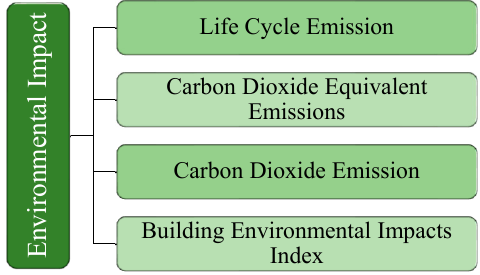
Figure 9. Environmental indicators.